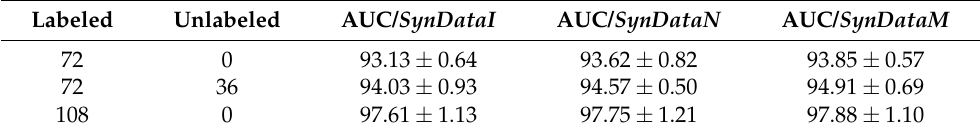
Table 4. AUC performance of GPGDA algorithm with and without the additional unlabeled data. Labeled